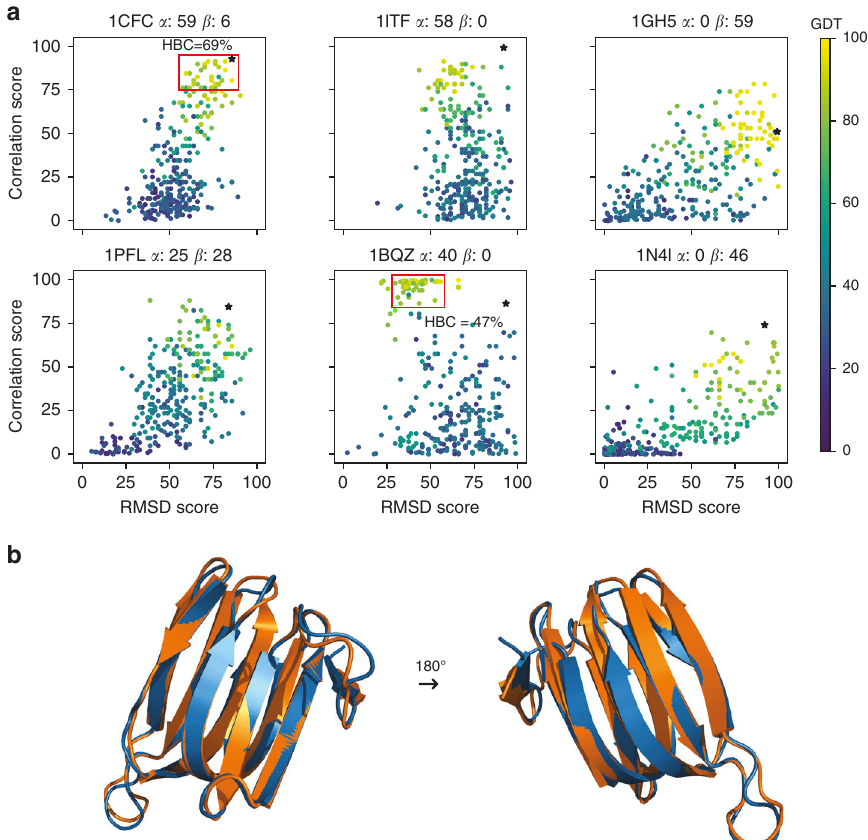
Fig. 3 Structural accuracy of decoys. a Each plot shows one protein, indicated by its PDB code and the percentage of α -helix and β -sheet in the experimental structure, according to DSSP 61 . The experimental structure is indicated by an asterisk and is the best scoring model in the NMR ensemble, according to our method. The other data show decoys generated by 3DRobot 32 , and color coded by their Global Distance Test (GDT), a measure of similarity to the target 33 , as indicated by the color bar on the right. For two proteins, red boxes indicate the set of decoys used to calculate mean hydrogen bond correctness, as discussed in the text. b A comparison of experimental structure (orange) and best decoy (blue) for the protein